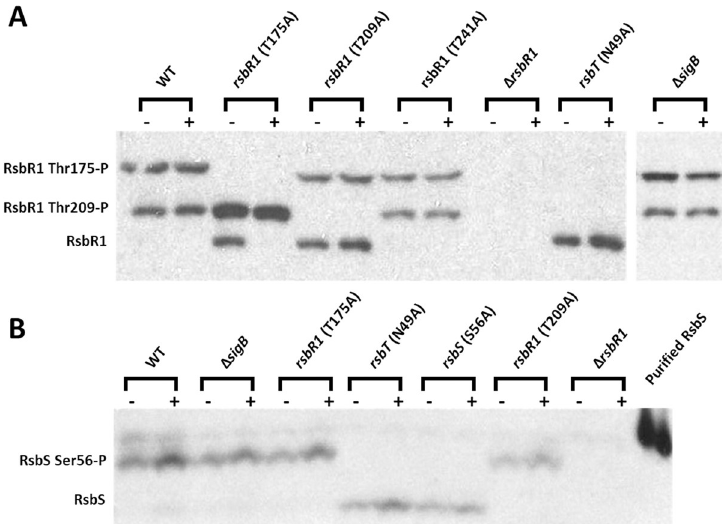
Fig 7. Phosphorylation of RbsR1 on residues T175, T209 and RsbS on residue S56 requires the kinase RsbT. Western blots probed with (A) anti-RsbR1 and (B) anti-RsbS antibodies. Wild type and all mutant strains were grown to mid-log phase at 37˚C in BHI and then untreated (-) or treated (+) at pH 5.0 for 15 min. Total protein extracted was separated in Phos-tag gels. The lower bands correspond to non-phosphorylated isoforms of RsbR1 or RsbS in the respective blots. The middle bands in anti-RsbR1 blots correspond to mono-phosphorylated RsbR1 at the T209 and the higher band corresponds to mono-phosphorylated RsbR1 at T175. The higher band on the RsbS blot corresponds to RsbS phosphorylated on S56. The Δ rsbR1 mutant extracts were included as negative controls since RsbR1 and RsbS are not expressed in this strain.